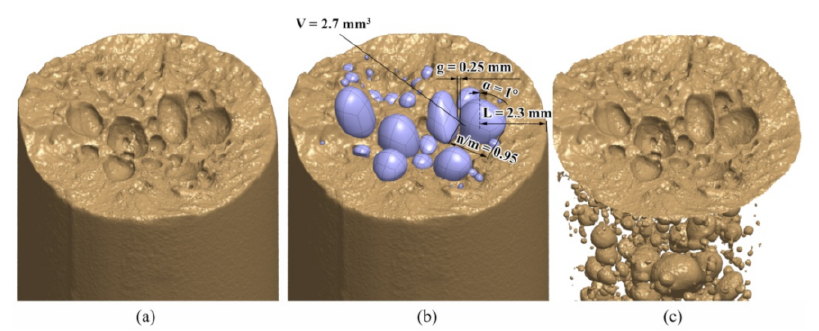
Figure 13. Assessment of critical areas with dimensions around the largest pore in sample no. 12. ( a ) raw data, ( b ) reconstruction of pores on the critical plane, ( c ) examination of the pores inside. Two combinations of pores (i.e., 2-2-1-2-3-4 and 4-1-3-3-3-3 from Figure 10)